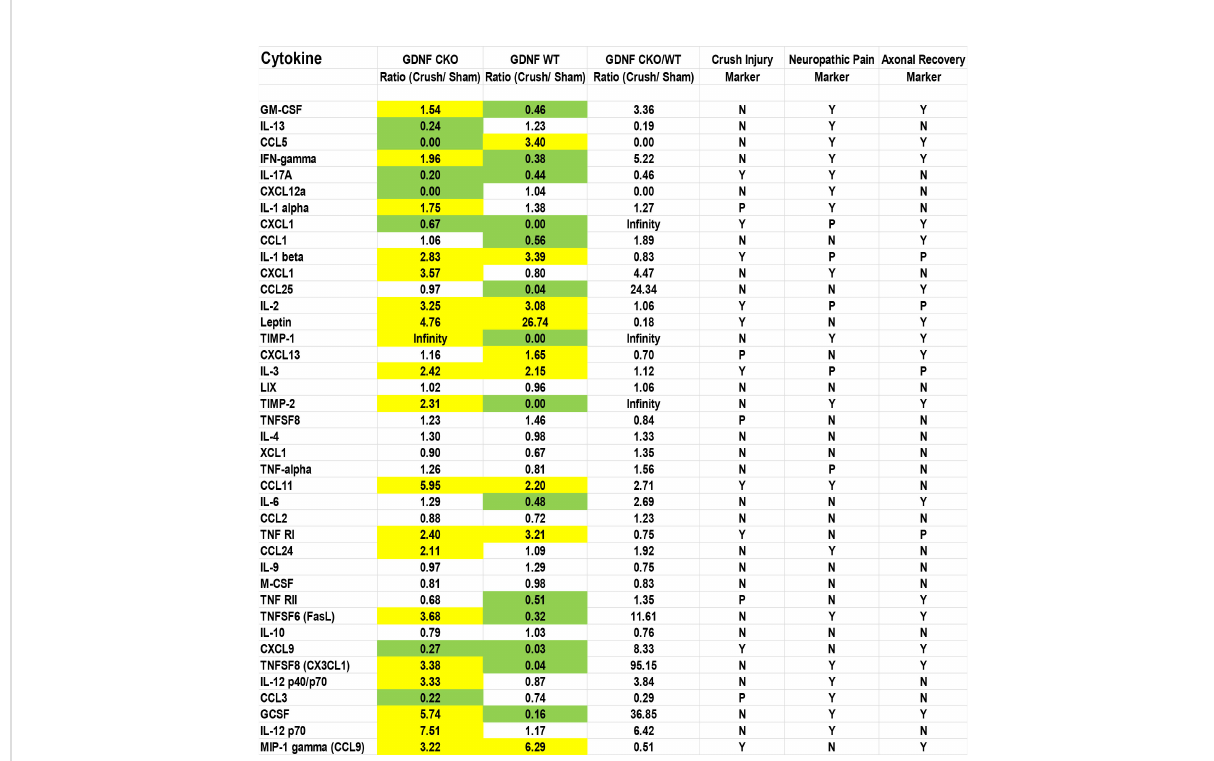
FIGURE 9 Sciatic nerve cytokine expression pro fi les in age- and sex-matched Gdnf CKO and Gdnf WT mice following unilateral crush injury. Whole sciatic nerve homogenate semi-quantitative cytokine array spot densitometry numerical data from a representative experiment show increased (1.5- fold up; yellow) or decreased (1.5-fold down; green) protein expression on day 7 following unilateral crush injury relative to uninjured Sham surgery nerves from the same mice. Maximal Gdnf expression occurs on day 7 following sciatic nerve crush. Cytokines that are increased or decreased in BOTH Gdnf CKO and Gdnf WT mice could be crush injury biomarkers. Cytokines that are either increased or decreased in Gdnf CKO mice with the opposite pattern in Gdnf WT mice could be persistent axonal degeneration or chronic nociception predictive biomarkers. Cytokines increased or decreased in Gdnf WT mice and the opposite pattern detected in Gdnf CKO mice could be predictive biomarkers of early axonal regeneration. N = No, Y = Yes, P = Possible. N = 4 (16 sciatic nerves in